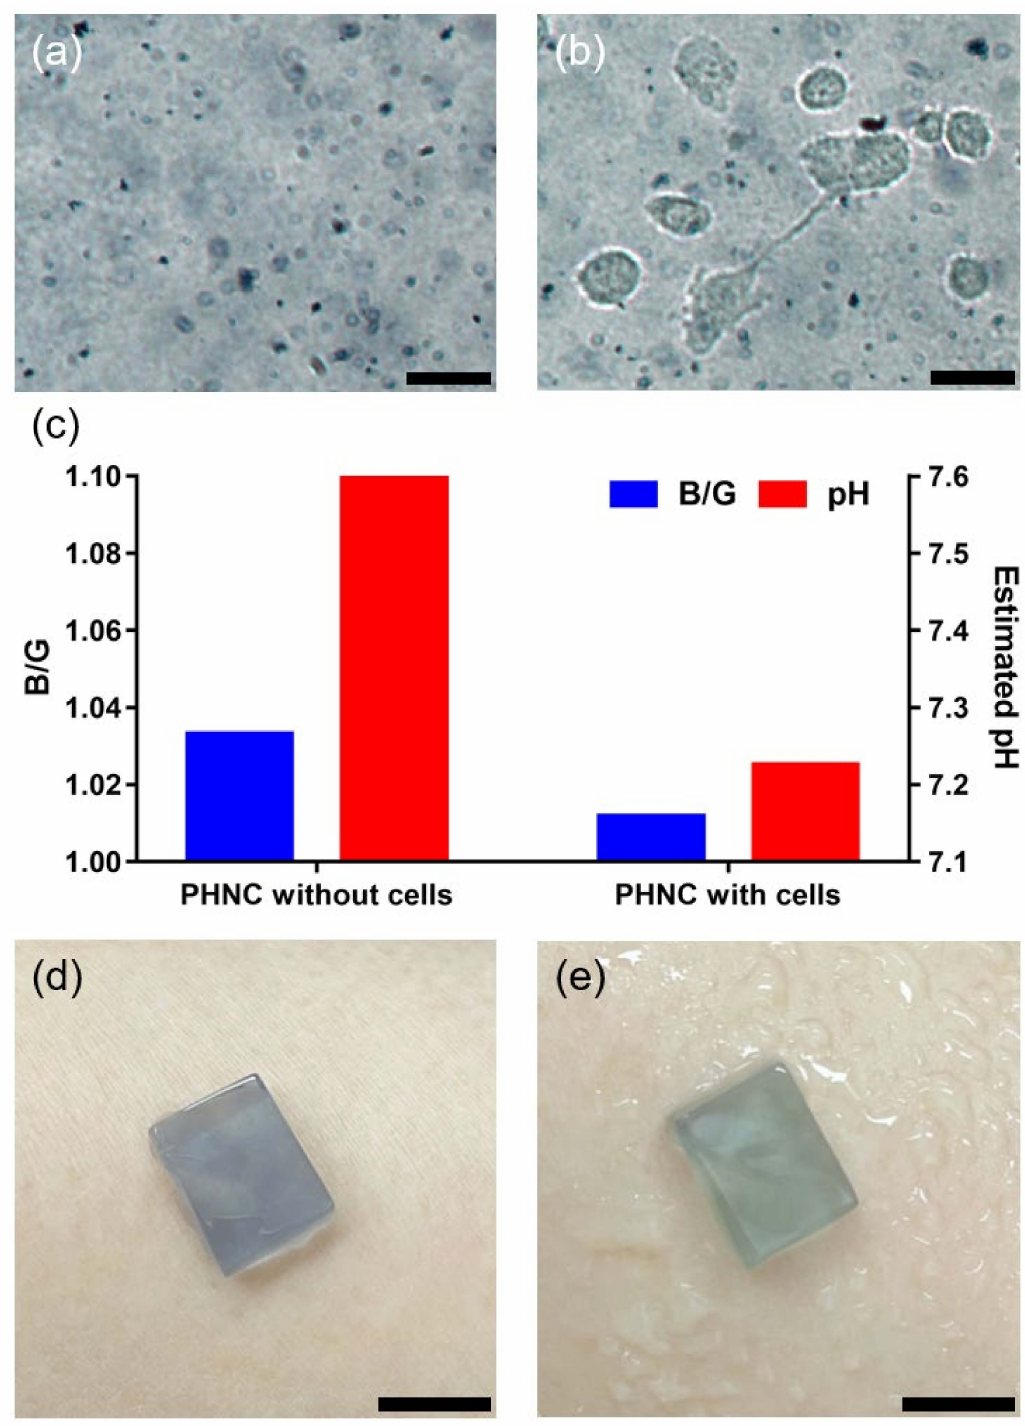
Figure 7. ( a ) PNHC without cells and ( b ) PNHC with cell for 6 h after cell attachment. Scale bar represents 40 µ m. ( c ) B/G of PNHC without and with cells and estimated pH from the B/G values using the model equation in Figure 6d. The signal intensity (B/G) is a ratio of the blue value divided by the green value; the color intensities were quantified using ImageJ software. Photographs of ( d ) the PNHC on the native skin of a human arm and ( e ) the PNHC after spraying artificial sweat solution. Scale bar represents 5